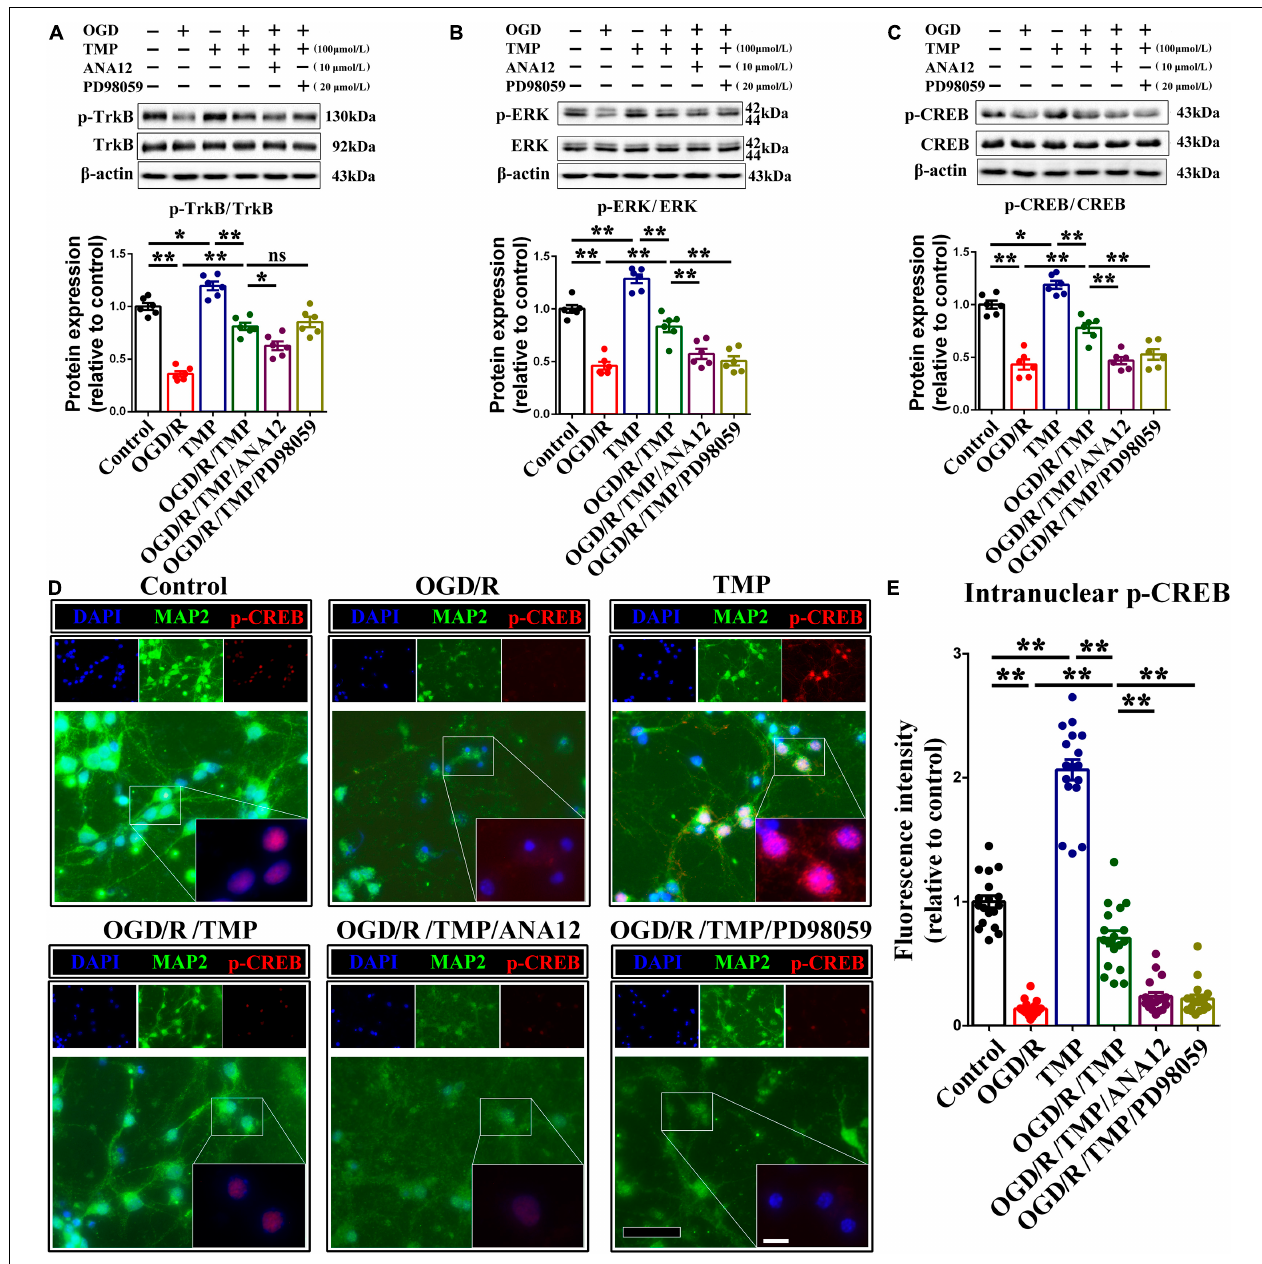
FIGURE 9 | Activation of TrkB/ERK/CREB signaling pathway protects neurons against injury induced by oxygen glucose deprivation (OGD) condition. (A–C) Representative immunoblots representing the expression and semi-quantitative analysis of proteins related to TrkB/ERK/CREB signaling pathway including p-TrkB (A) , p-ERK (B) and p-CREB (C) in different groups. (D) Representative immunostaining exhibiting the colocalization of MAP2 (green) and p-CREB (red) in each group. Nuclei were counterstained with DAPI. Scale bar: Scale bar: 50 µ m; and 20 µ m for enlarged inserts. (E) Quantification of optic intensity of intranuclear p-CREB in various groups. Data are presented as mean ± SE. n = 6 per group, * P < 0.05, ** P < 0.01.